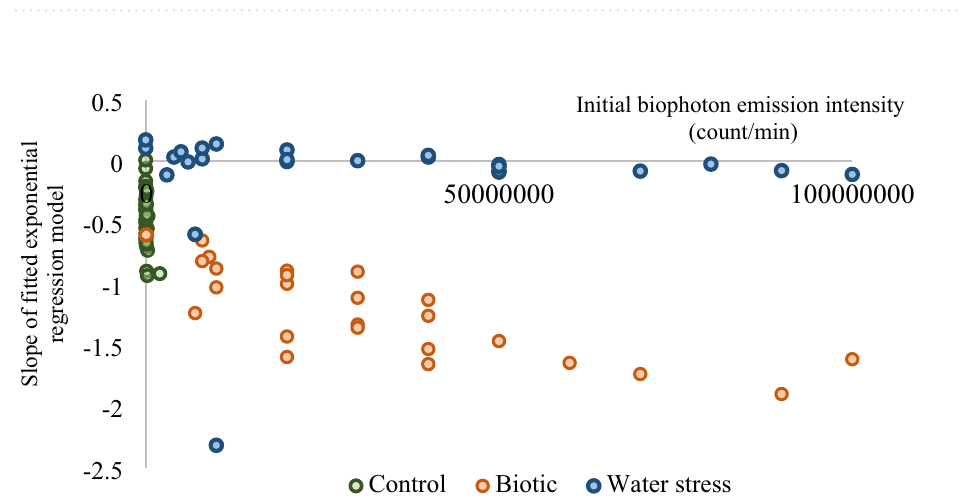
Table 2. Standard deviation of biophoton emission intensity on Leaf A and Leaf B, in different experimental groups (Control, Biotic stress, Water stress) in each time step.